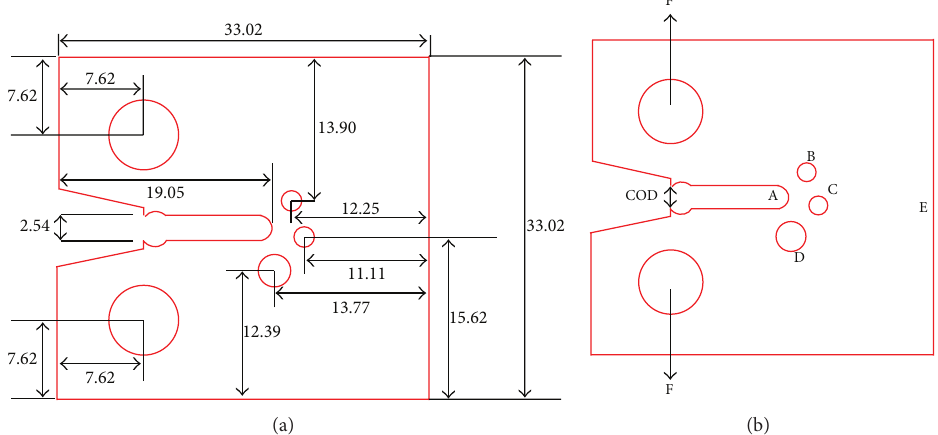
Figure 1: Nominal dimensions of the challenge specimen with 3.18 mm nominal thickness. All dimensions are in millimeters. Figure was adapted from the SFC lead article